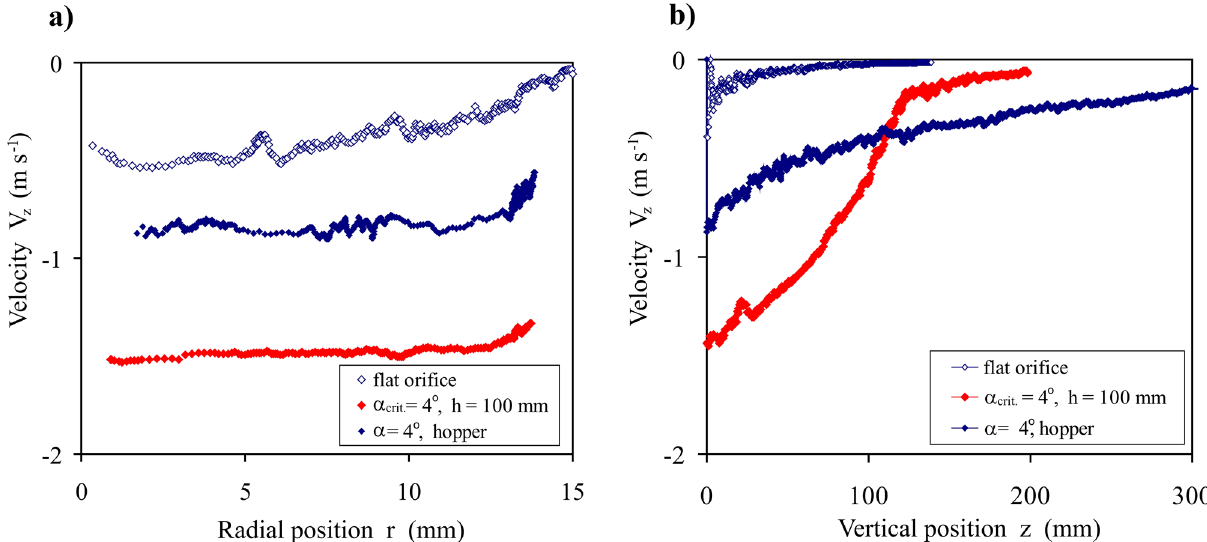
Figure 9. Profiles of the vertical velocity V z averaged over ten moments of time, for the orifice of d 0 = 32.5 mm: ( a ) in radial direction r at the level of the bottom edge of the orifice, ( b ) in vertical direction z (averaged over the cross-section of the